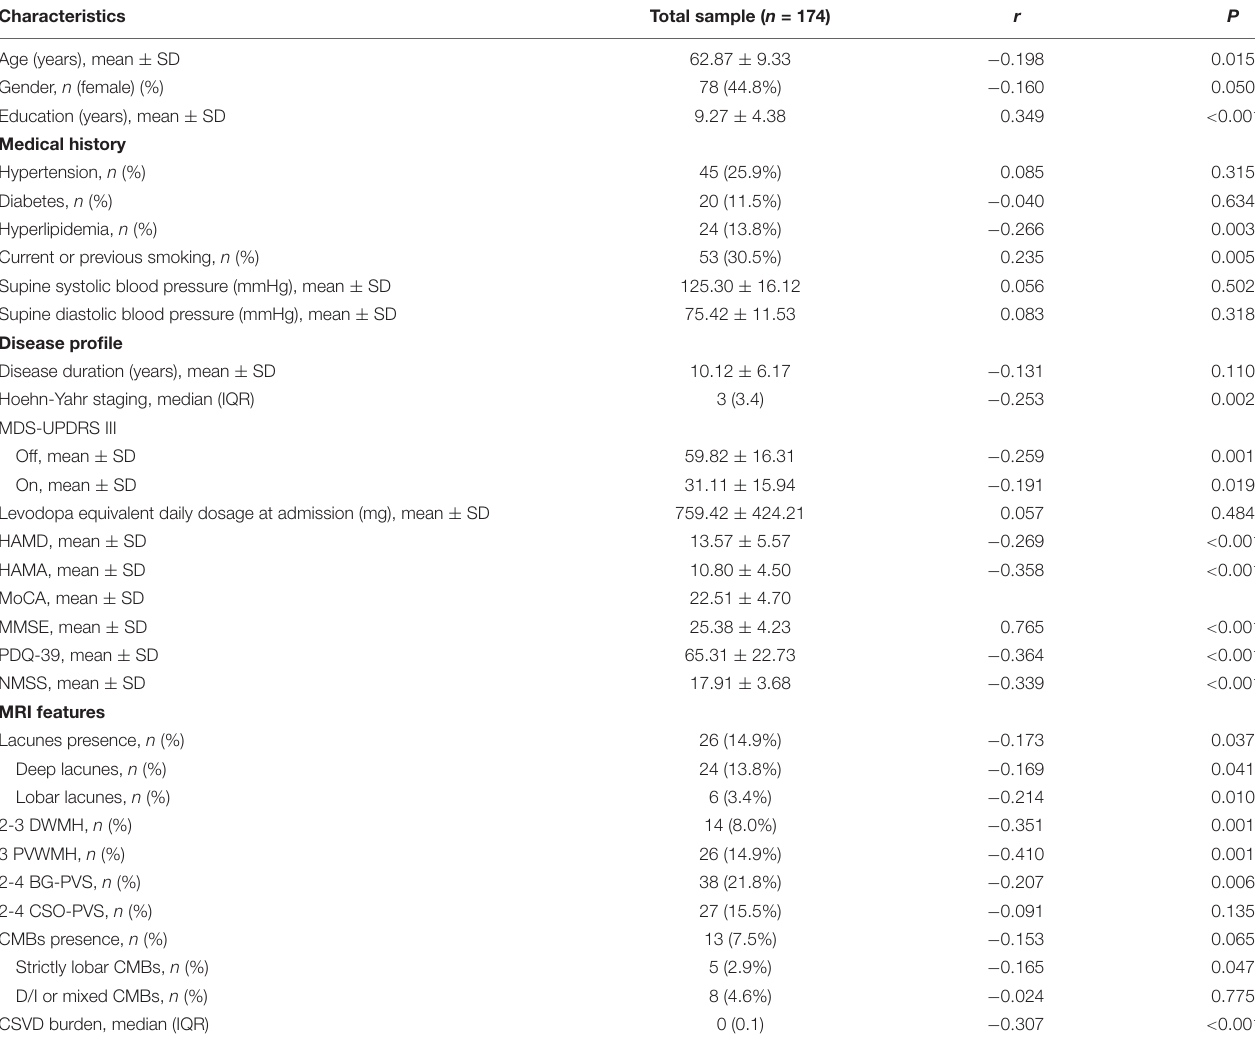
TABLE 1 | Demographic profiles of PD patients and Spearman’s correlation with MoCA score. Characteristics